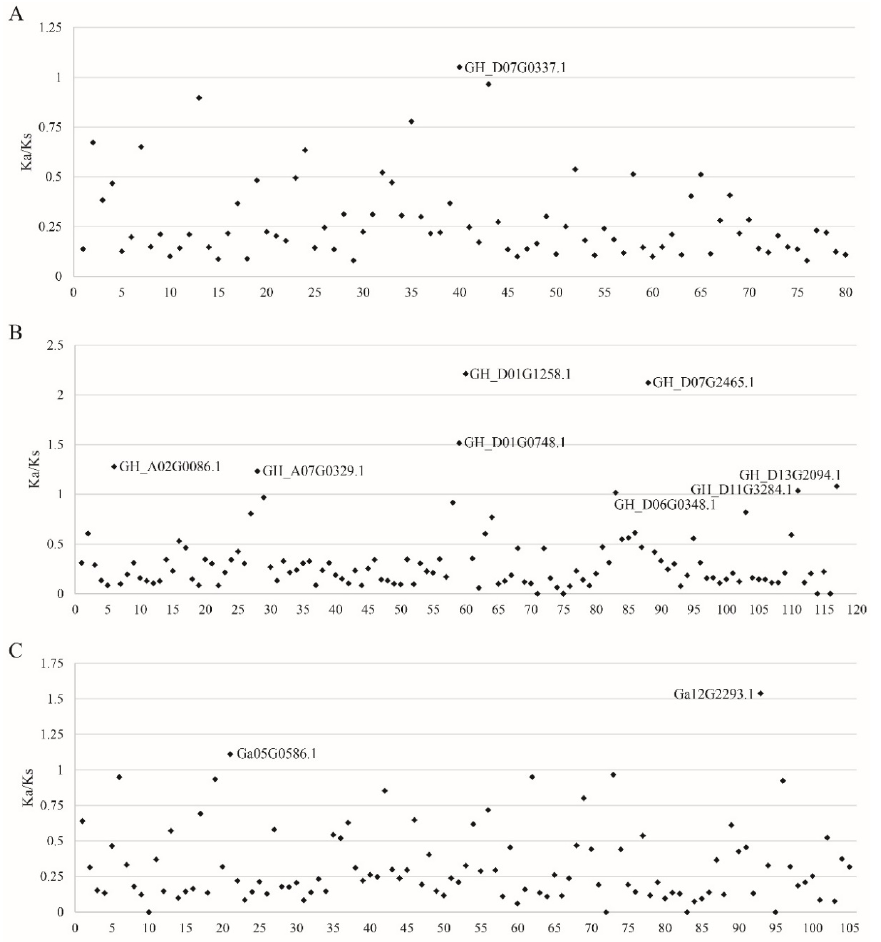
Figure 5. The distribution of Ka/Ks ratio of orthologous pairs between GhFBXL , GrFBXL , and GaFBXL . ( A ) Ka/Ks analysis of GhFBXL-GhFBXL . ( B ) Ka/Ks analysis of GhFBXL-GrFBXL. ( C ) Ka/Ks analysis of GhFBXL-GaFBXL.